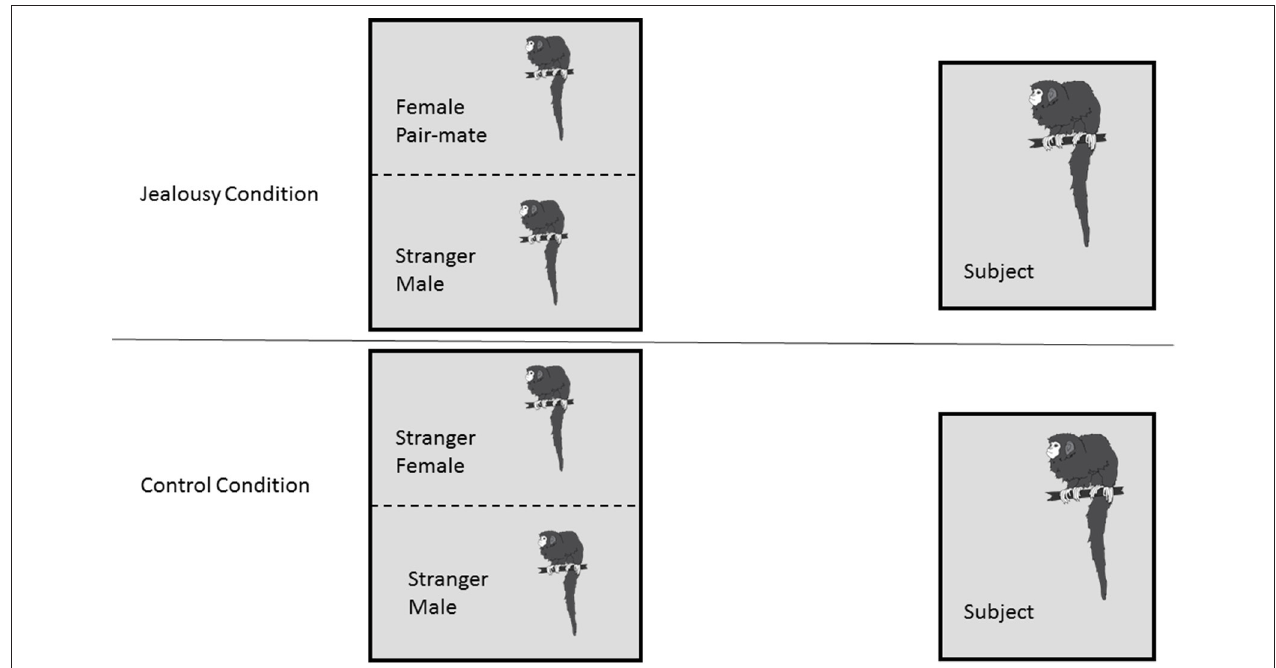
FIGURE 1 | Research Design. Subject males ( n = 8) each underwent two conditions: a jealousy condition and a control condition. In the jealousy condition, they viewed their female pair mate next to a stranger male. In the control condition, males viewed two stranger animals, a stranger male and stranger